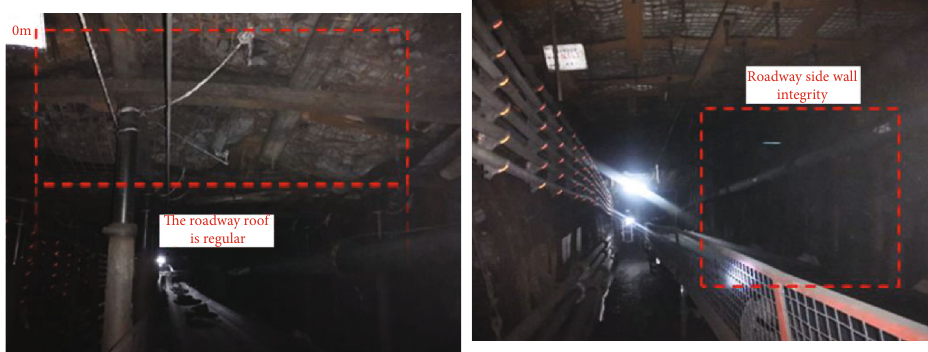
Figure 13: Field support e ff ect on the working